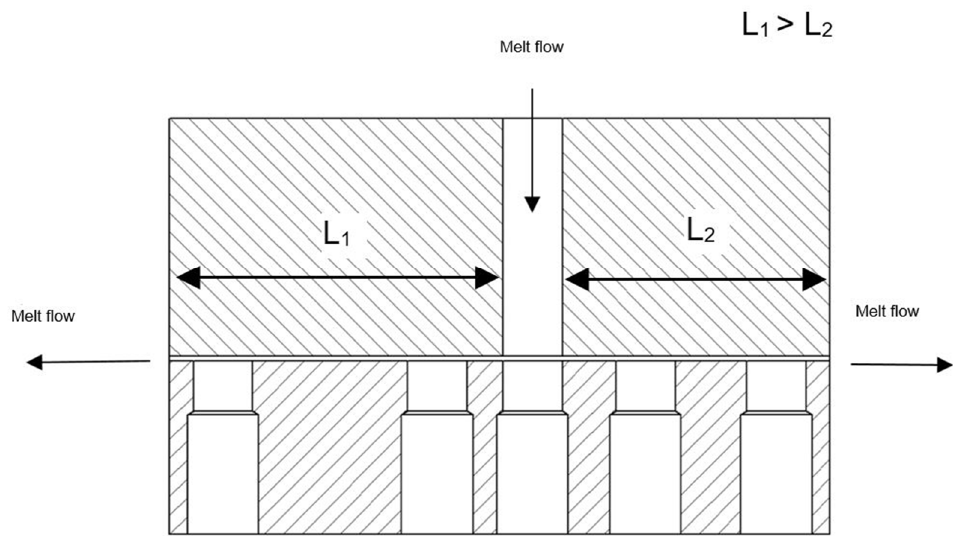
Figure 3. Die for the capillary rheometer with different melt path lengths [19]. By reducing the advance of the piston, it can be achieved that the melt stagnates on one side of the die while it is still flowing on the other side. 177